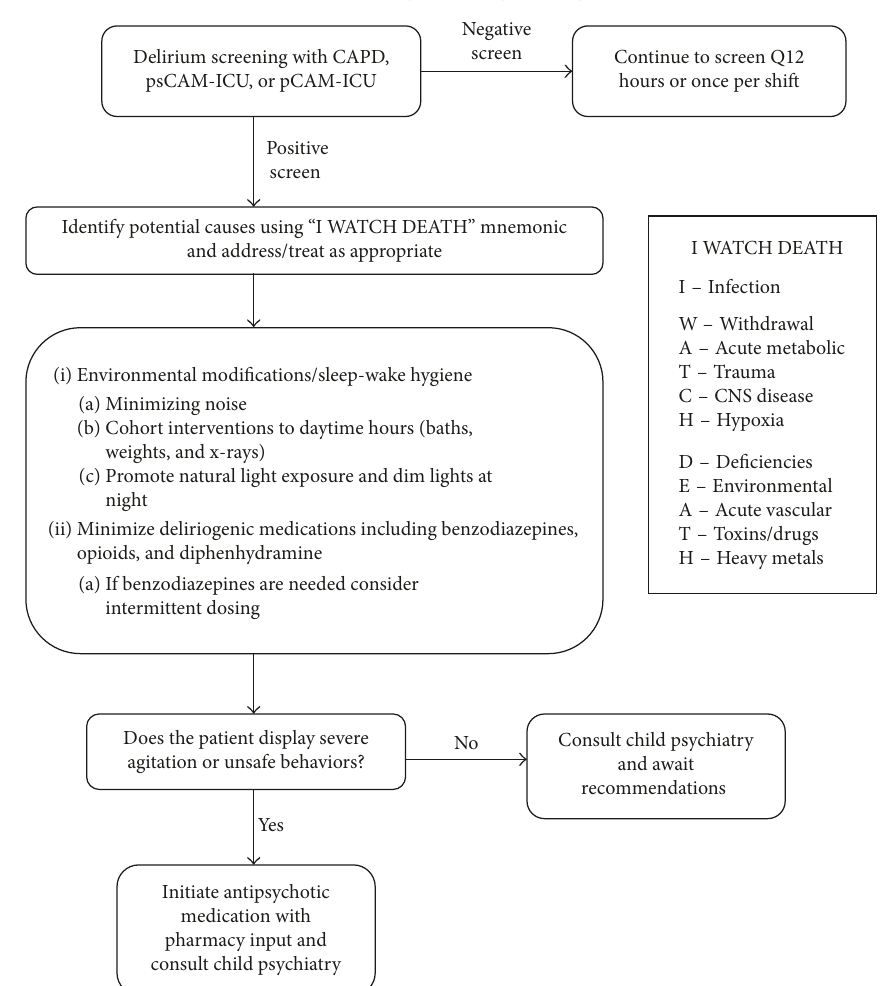
Figure 1: Delirium screening and management algorithm. CAPD Confusion Assessment Method for the Intensive Care Unit, psCAM-ICU Unit; CNS central nervous system; Q12 (cid:31)